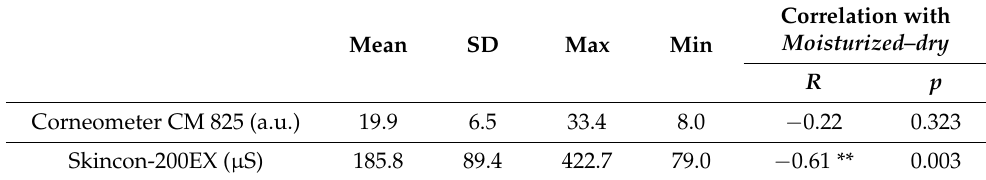
Correlation with Moisturized–dry R p